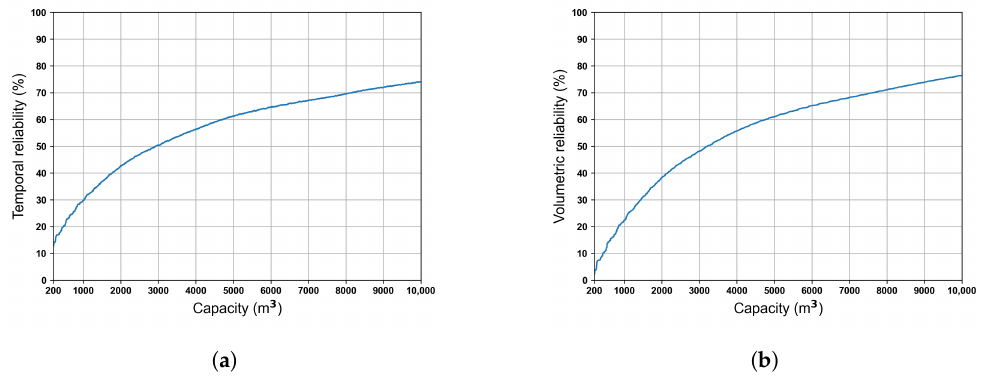
Figure 6. The capacity–reliability curves for the considered rainwater harvesting system: ( a ) the capacity–temporal reliability curve; ( b ) the capacity–volumetric reliability